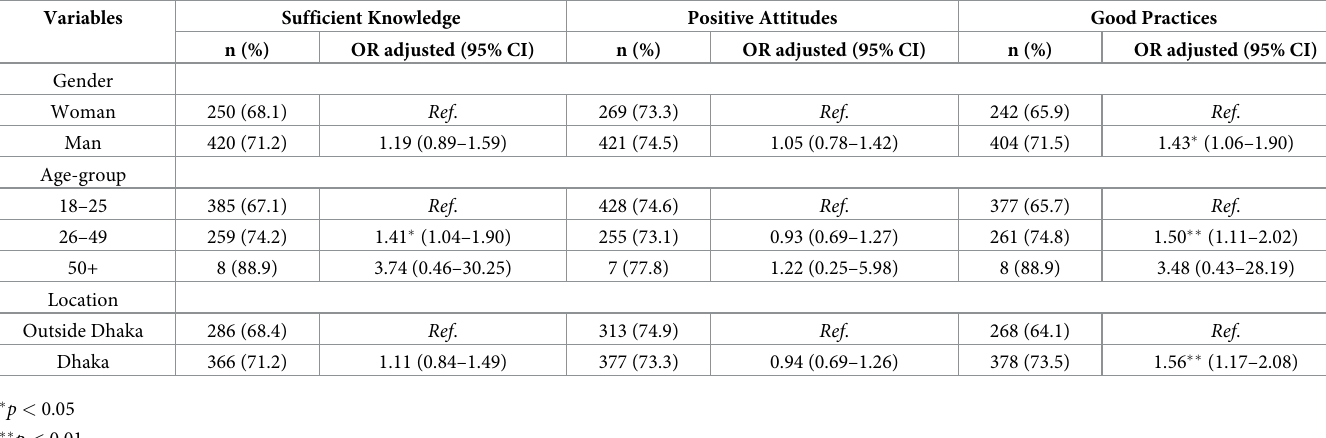
Table 6. Estimated parameters of multiple logistic regression on different factors. Variables Sufficient Knowledge Positive Attitudes Good